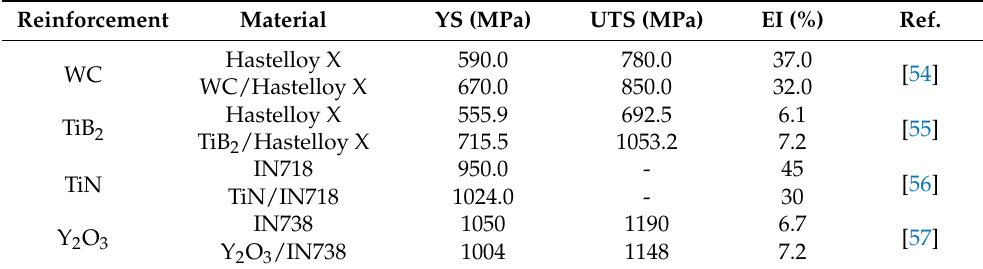
Table 1. Mechanical properties of NAMMCs reinforced with different ceramic particles.